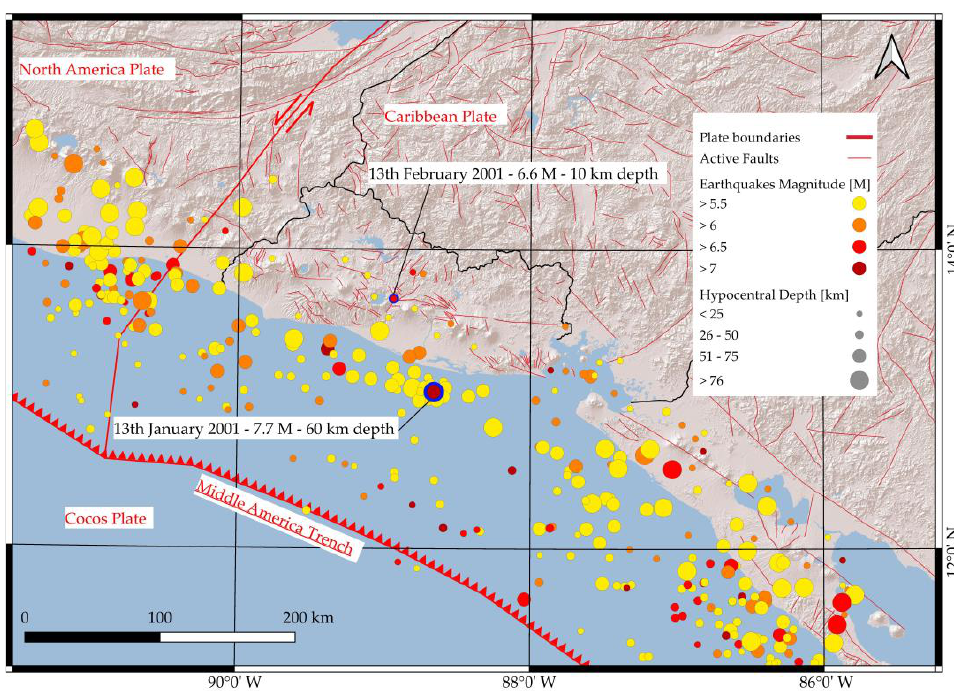
Figure 3. Main earthquakes (Mw > 5.5) that affected El Salvador. The earthquakes that hit the country on 13 January and 13 February 2001 are highlighted. Exactly one month later, on 13 February 2001, El Salvador experienced another intense earthquake, which increased the destruction experienced by the country. This event, originating from the second source of seismicity, had a Mw of 6.6, with a hypocenter placed at a depth of 10 km. This earthquake resulted in 315 fatalities and injured 3399 people due to ground-shaking and landslides (Figure